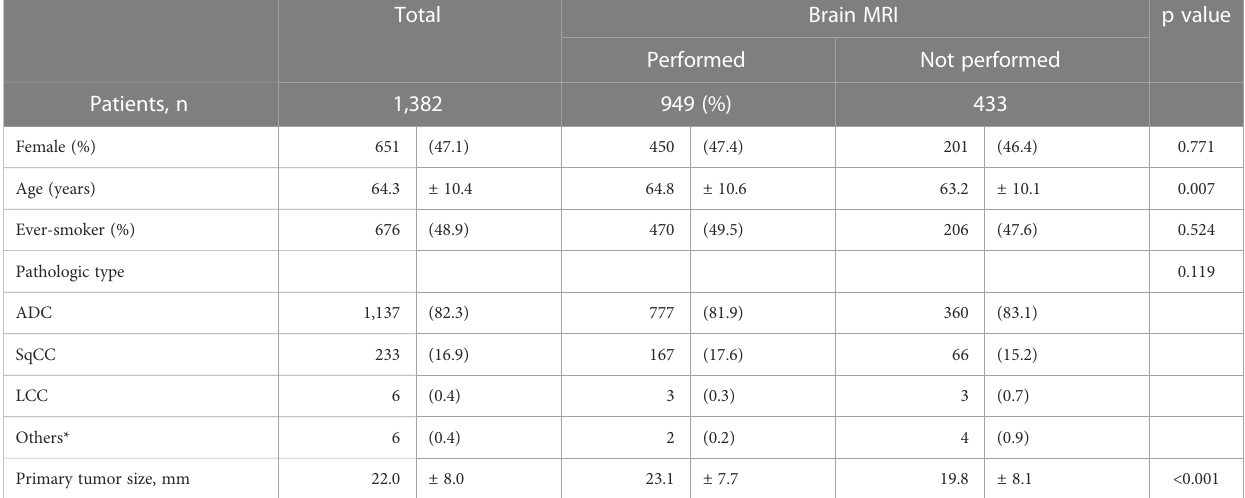
TABLE 1 Clinical characteristics of the study